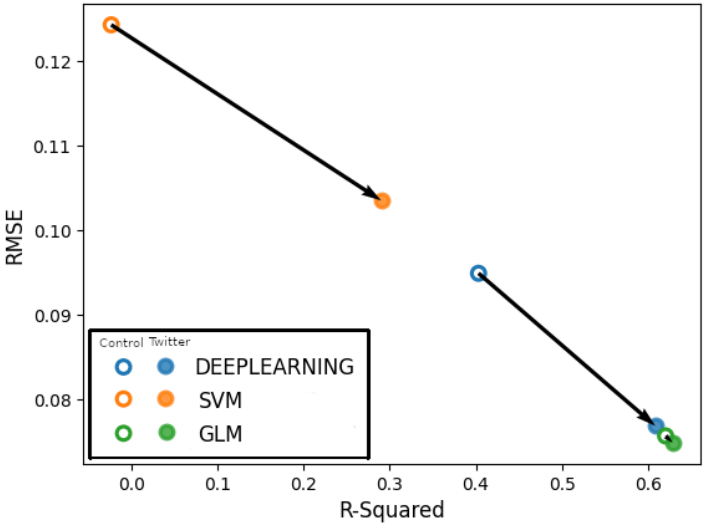
Figure 17. Overall performance comparison of Model 10 w.r.t control run model on data from January–April